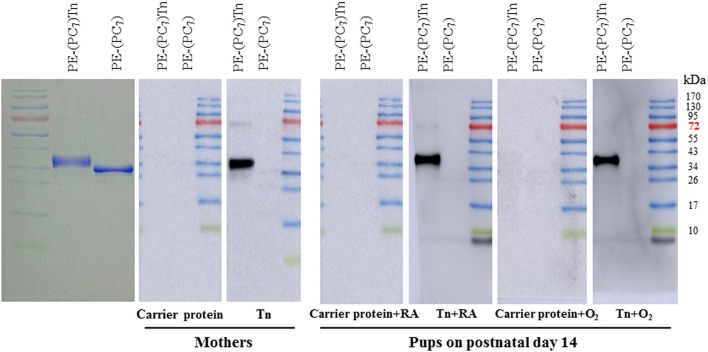
Western blot analysis of serum anti-Tn antibody in dams and rat pups on postnatal day 14. PE-(PC7)Tn predominantly recognized one major band (anti-Tn antibody), which was not recognized by PE-(PC7). Mothers and pups who received Tn immunization exhibited a dense anti-Tn antibody band, whereas mothers and pups who received carrier protein immunization did not exhibit anti-Tn antibody. The diagram illustrates representative data from three experiments.